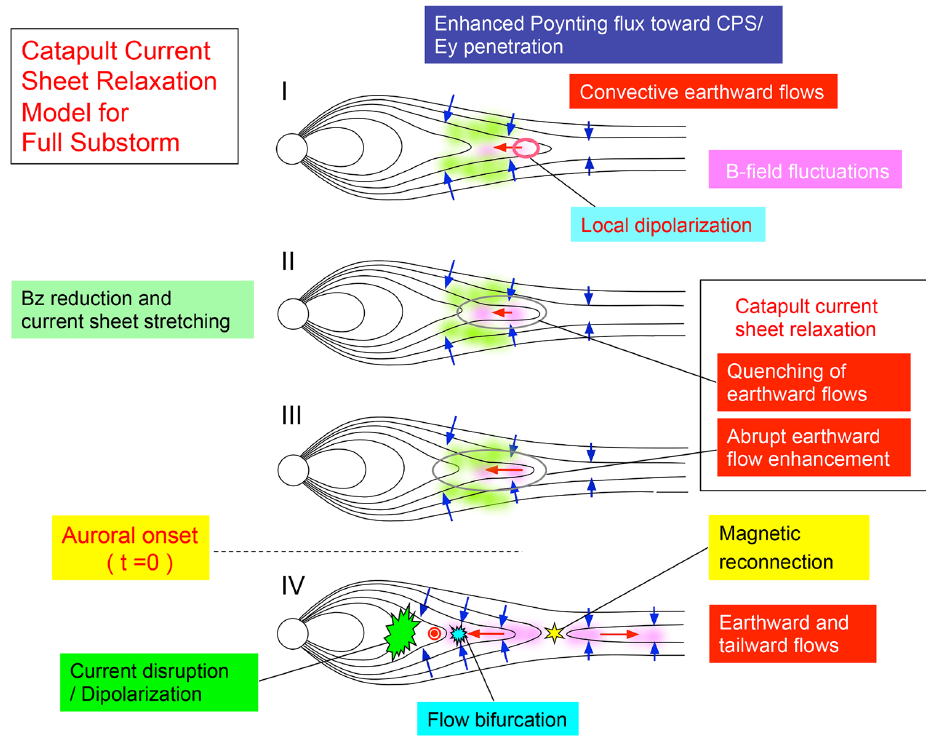
Fig. 9. Schematic illustration of the catapult current-sheet relaxation model. See the text for